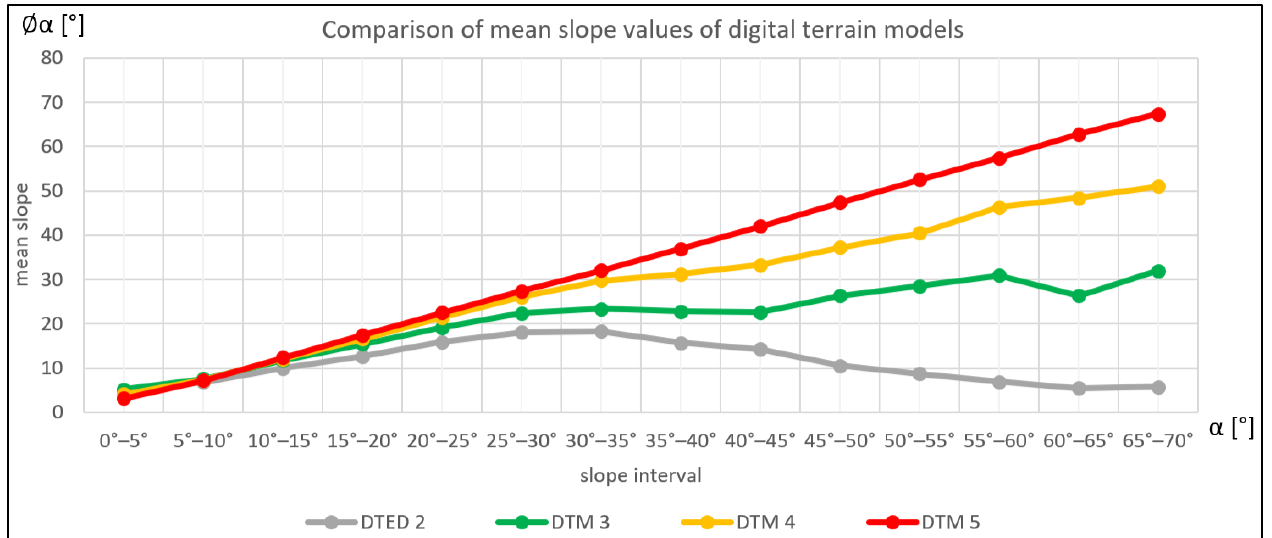
Figure 5. Graph comparing mean slope values of different terrain models (DTM 5, DTM 4, DTM 3, DTED 2) at identical points. Slope classes were determined from DTM 5.